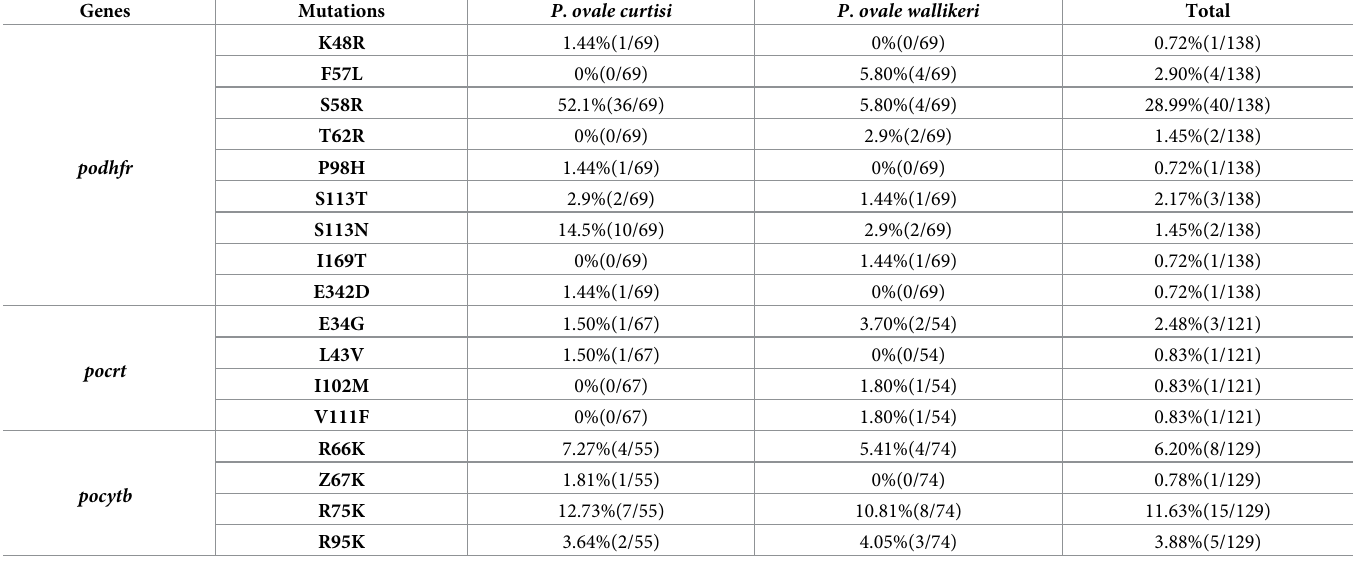
Table 2. Mutations of podhfr , pocrt and pocytb in P . ovale curtisi and P . ovale wallikeri isolates. Genes